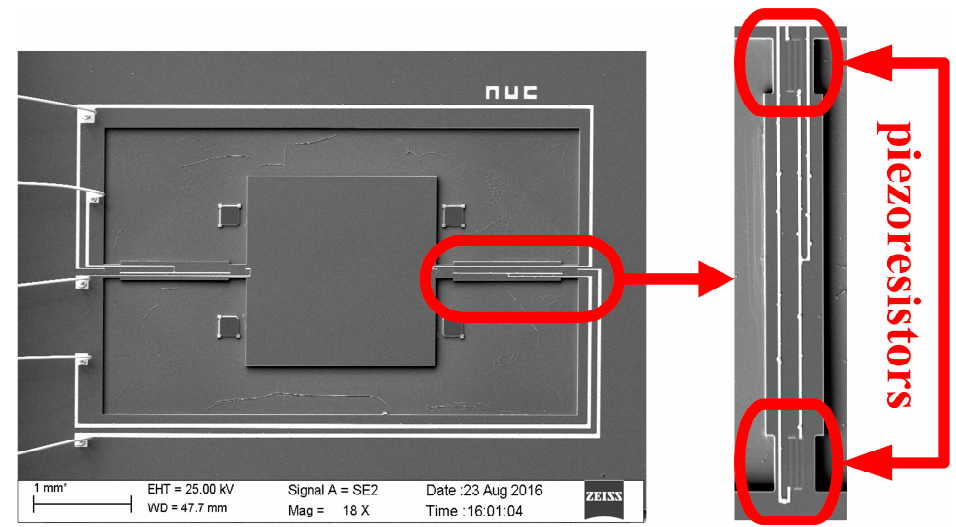
Figure 10. MEMS microstructure.